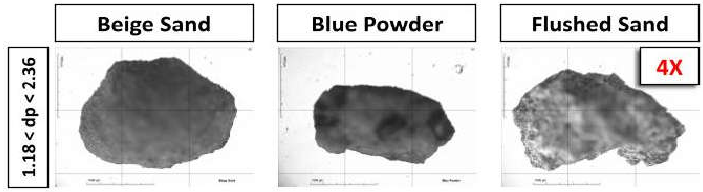
Figure 4. Representative sands grains images obtained with optical microscopy.